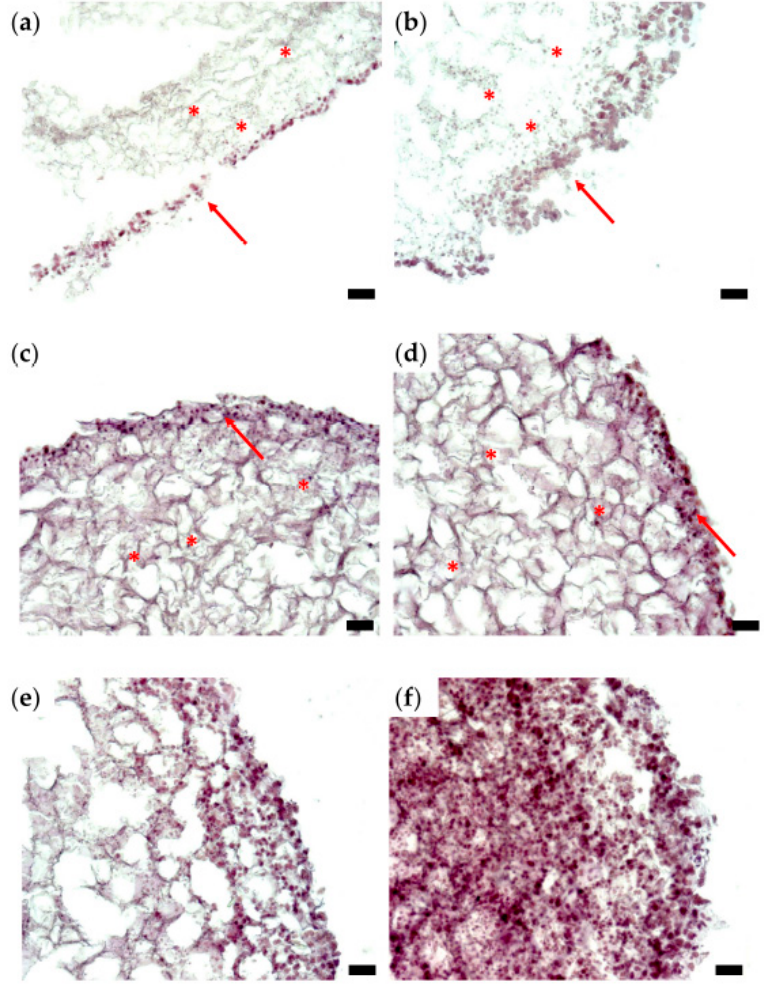
Figure 5. Histological analysis of representative sections of a triple-layered tissue construct (HE staining): ( a , b ) day 6; ( c , d ) day 10; ( e , f ) day 14; optical microscopy, ob. 10×, scale bars = 10 µm. Stars indicate cellular distribution on the inner part; arrows point to the exterior part of the structure, which is intensely populated with cells.